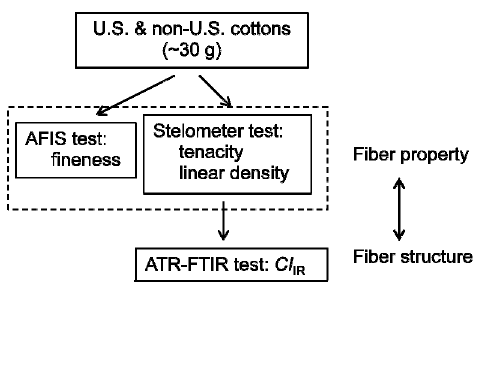
Figure 1. A flow chart of experimental